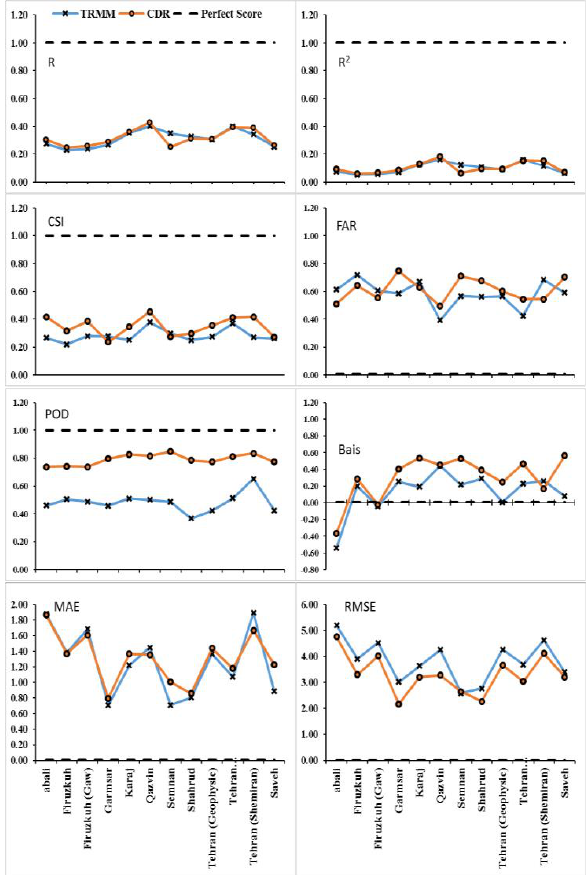
Figure 2. Daily precipitation statistics for each satellite product (CDR and